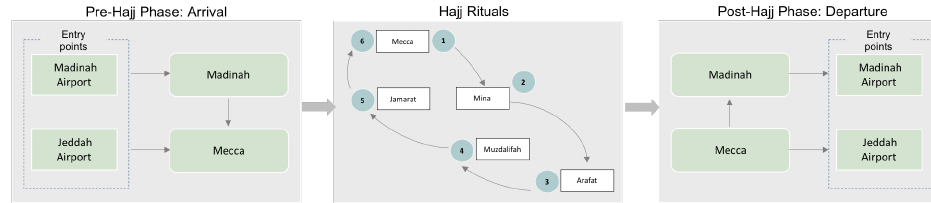
Figure 2. The main rituals and phases of the global event of